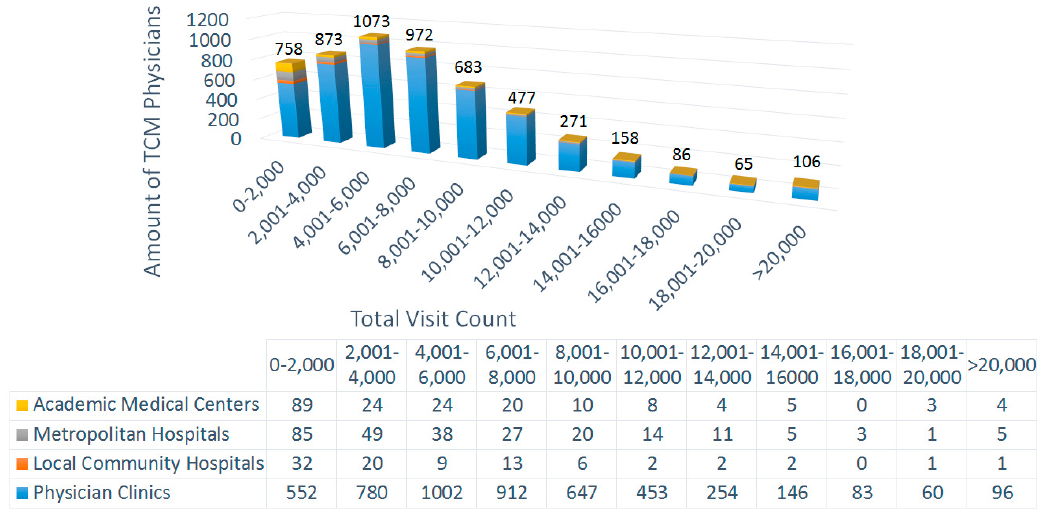
Figure 2. Analysis of total traditional Chinese medicine (TCM)-related visit counts and medical institution type in which care was provided by each TCMP in Taiwan in 2012.